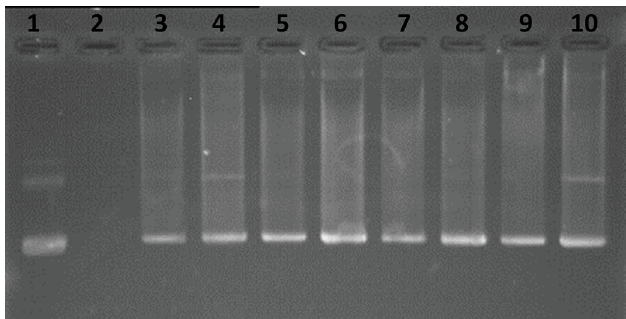
:DNA complexes. EQ1